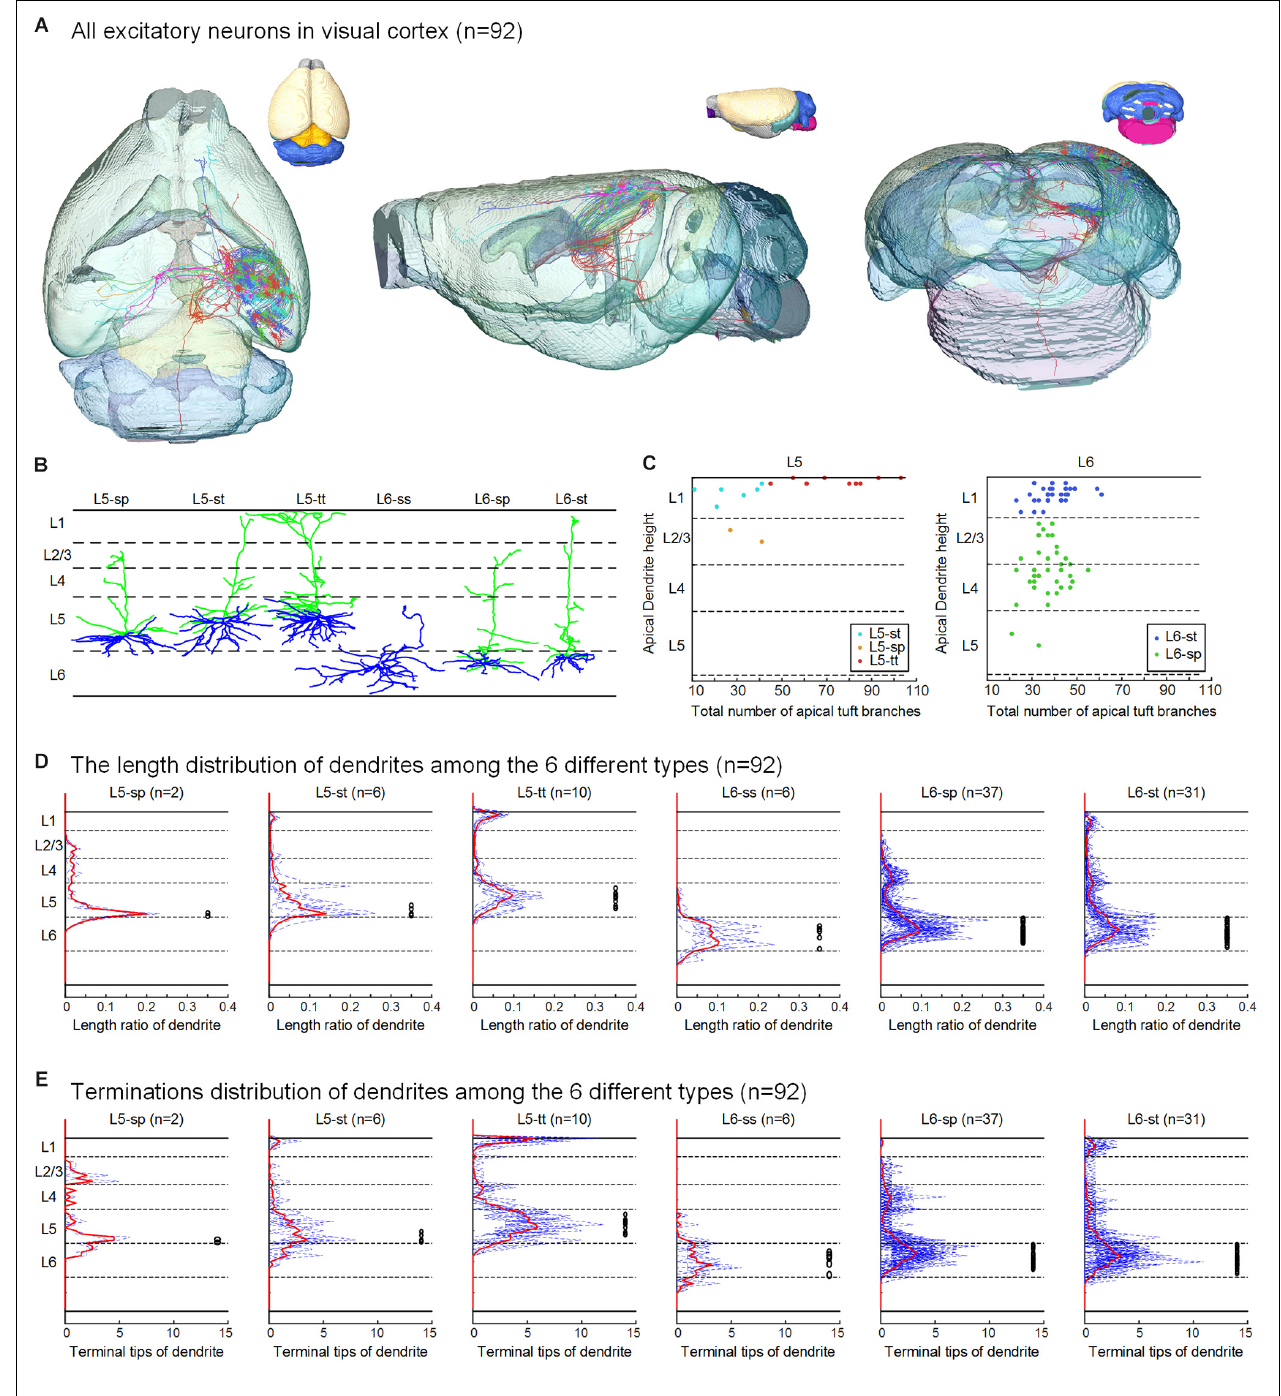
FIGURE 2 | Excitatory neurons in the visual cortex and their classification based on dendritic features. (A) The 92 neurons with their complete morphologies are shown in the mouse brain, the six colors of neurons represent the six types defined in (B) , and the different colors of the mouse brain represent the mapped brain regions according to the Allen Reference Atlas. (B) According to the layer of the cell body and the dendrite morphology, the reconstructed neurons are separated into six categories: star pyramidal cell in layer 5 (L5-sp), slender-tufted pyramidal cell in layer 5 (L5-st), tufted pyramidal cell in layer 5 (L5-tt), spiny stellate-like cell in layer 6 (L6-ss), star pyramidal cell in layer 6 (L6-sp), and slender-tufted pyramidal cell in layer 6 (L6-st). (C) Scatter plots with the two parameters: the relative height of the apical dendrites and the number of apical dendrites. The L5-sp, L5-st, L5-tt, L6-sp, and L6-st neurons show relatively clustered groups. (D) Laminar percentage distribution of dendritic L5-sp, L5-st, L5-tt, L6-ss, L6-sp, and L6-st neurons. For each type of neuron, the solid red line is the mean result, and the black circles to the right indicate the location of somata. (E) Laminar distribution of dendrite terminals of the 6 types of neurons.